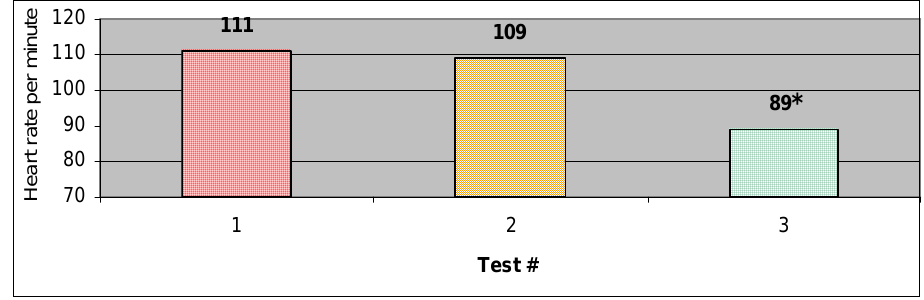
Graph 1. Change in resting heart rate before and after a treadmill intervention program, all participants.